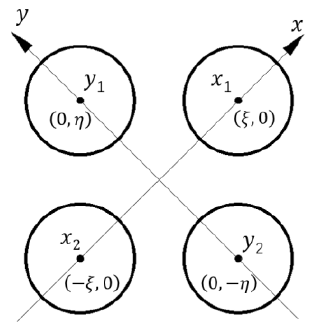
Figure 3. Schematic diagram of the relative positions of the four apertures in the exit pupil plane .